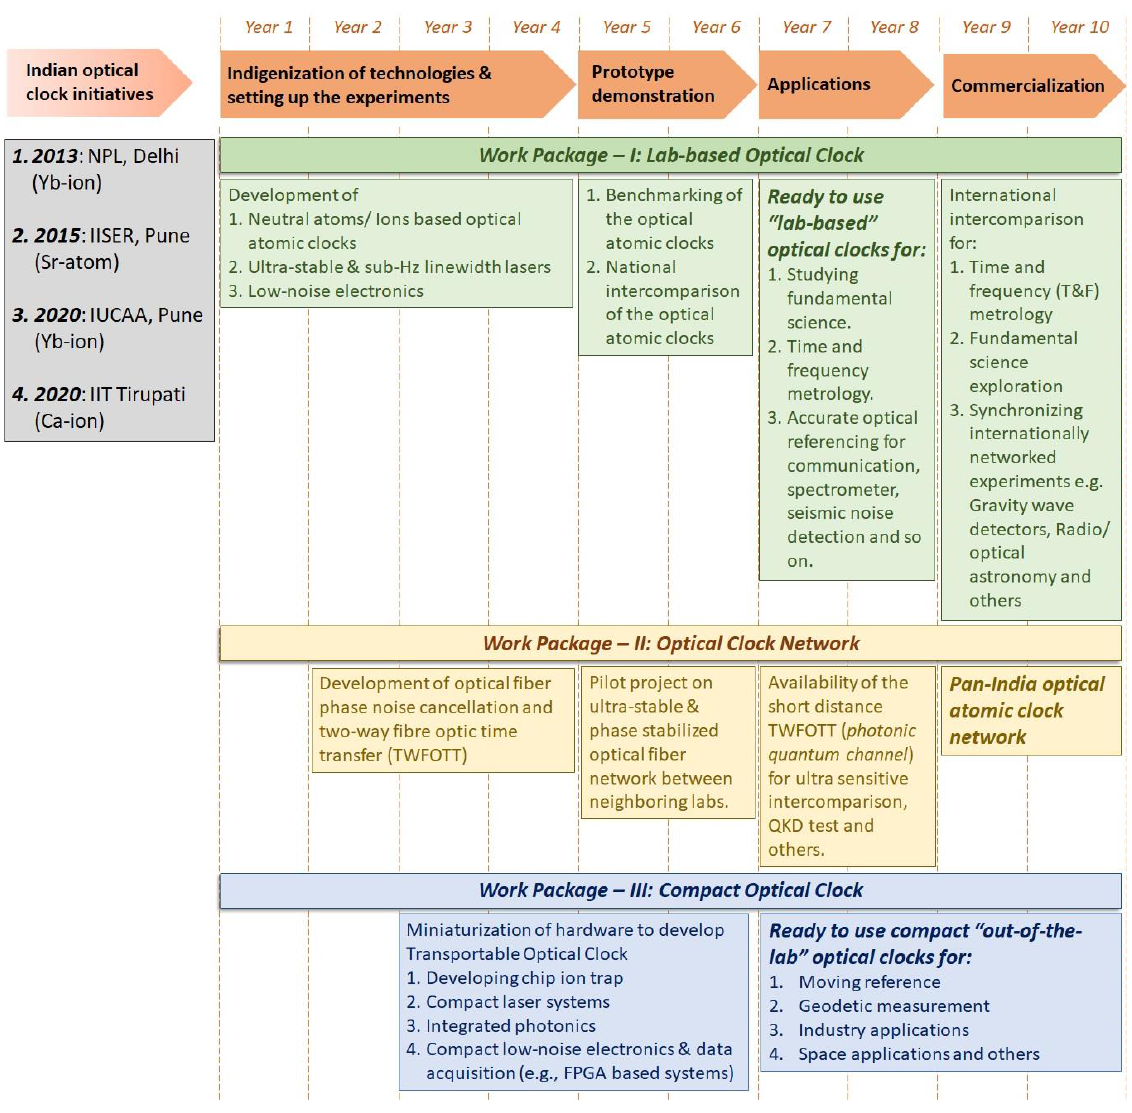
Figure 4. A proposed ten-year roadmap for indigenisation of optical clock technologies categorised into three distinct work packages: ( i ) lab-based optical clocks, ( ii ) optical clock networks, and ( iii ) compact optical clock developments.